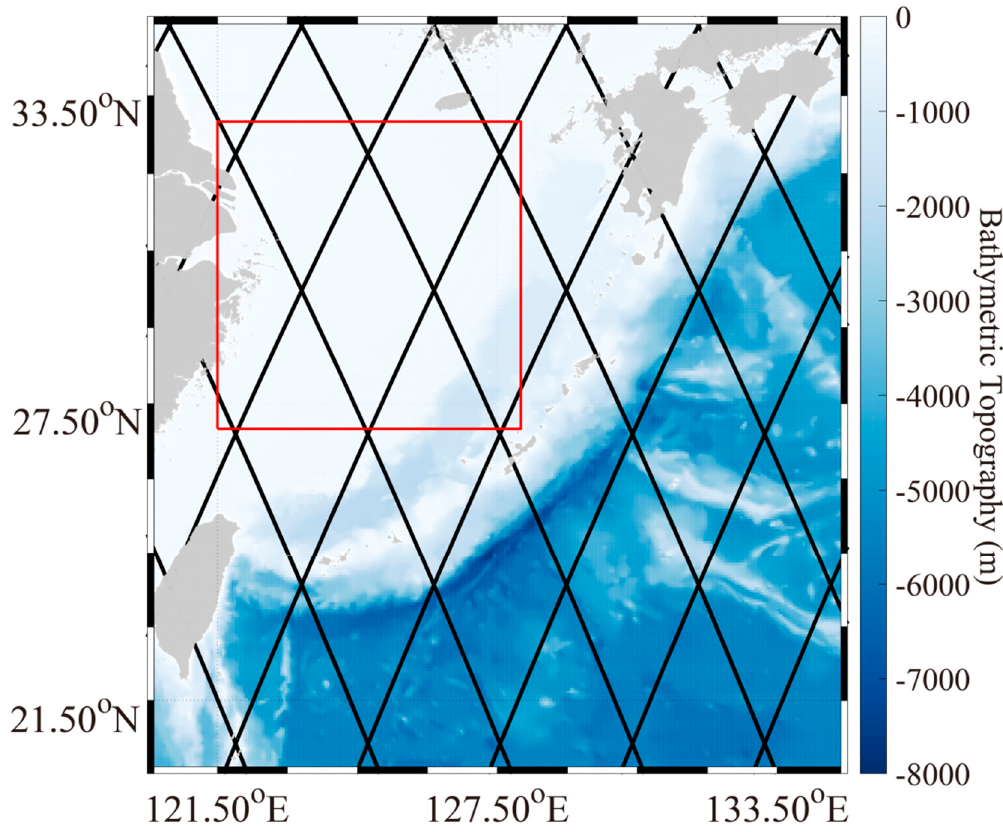
Figure 5. Footprints from the Jason-2 altimeter overlaid on the water-depth map of September 2014, in which the red square encloses the waters around the Zhoushan Islands.